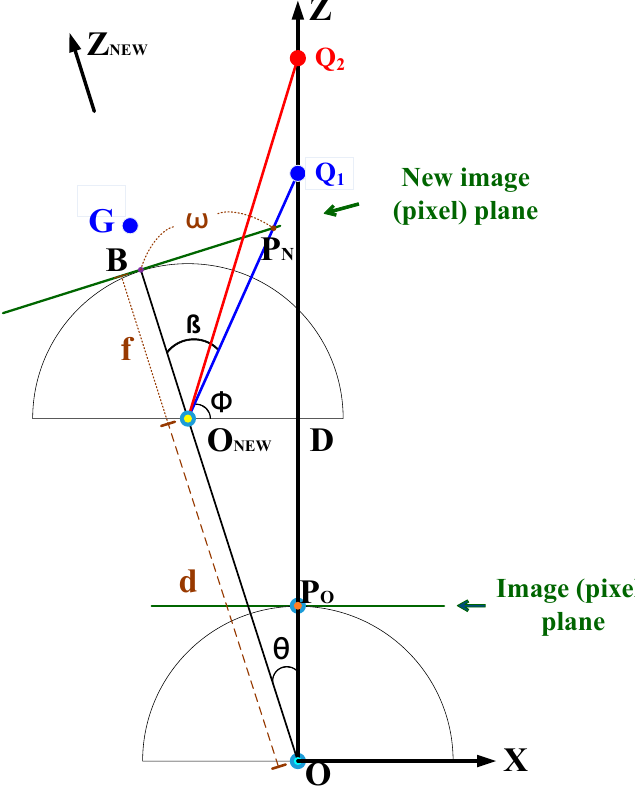
Figure 7. The top view depiction of robot movement.